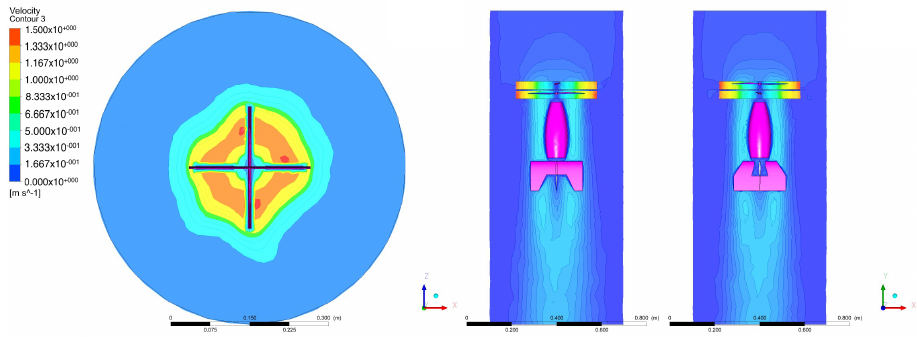
Figure 9. MCR UAV v3.0 velocity-scaled